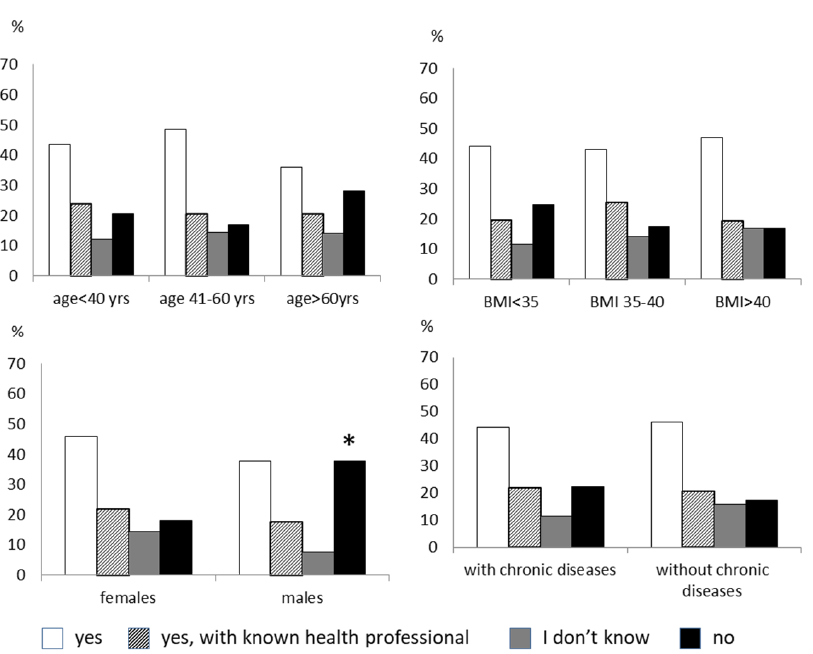
Figure 2. The figure shows the answer to the question: “Would you undergo a remotely delivered psychological intervention?”. The responders are divided by age, sex, degree of obesity, and the presence of chronic diseases. * p < 0.005 vs. females.